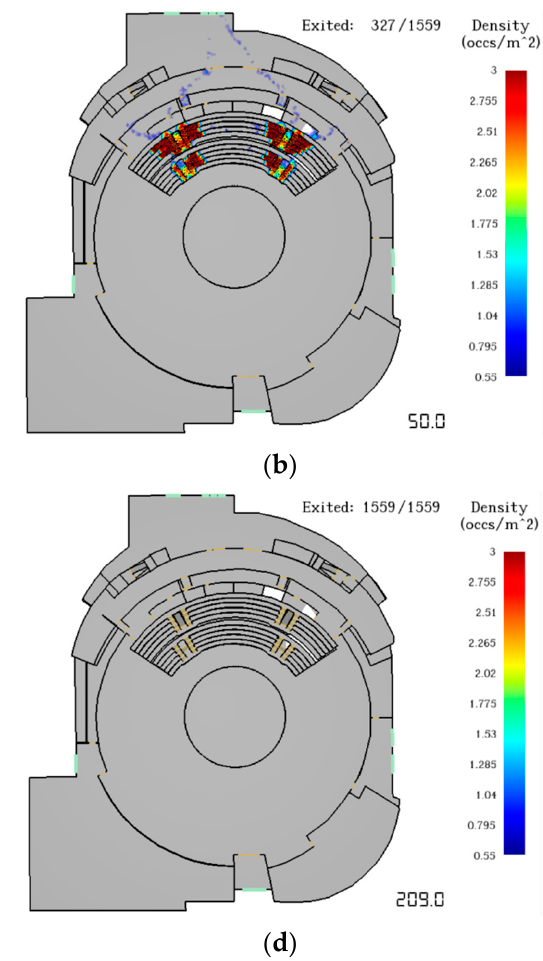
Figure 18. Distribution of the number of people passing through each exit on the first floor of Cas- es 1A~1D. ( a ) Number of occupants in Case 1A; ( b ) number of occupants in Case 1B; ( c ) number of occupants in Case 1C; ( d ) number of occupants in Case 1D.